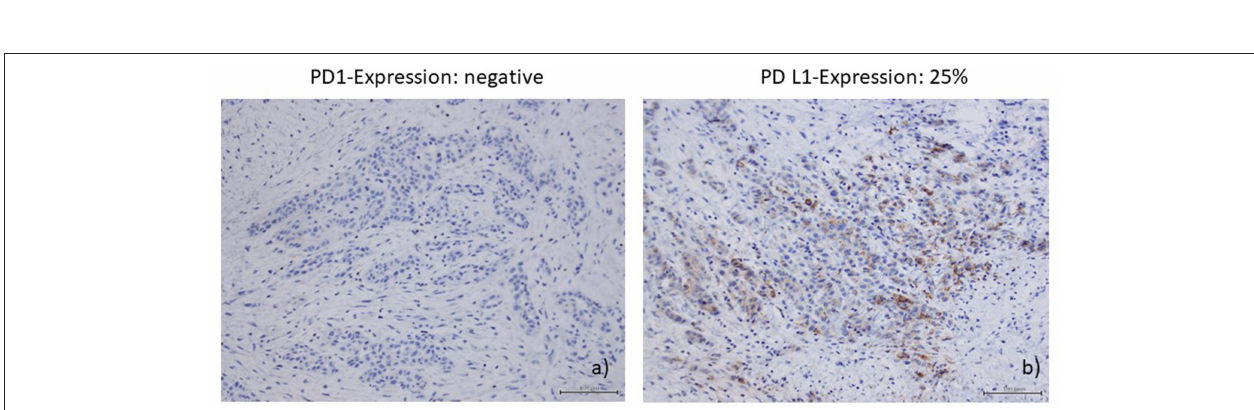
FIGURE 1 | MR.I T1 (a) progression under nivolumab monotherapy before start of nivolumab and ipilimumab; (b) partial remission under nivolumab and ipilimumab after 2 cycles; (c) ongoing stable disease 2 years after start of combination therapy and 7 months after end of treatment.